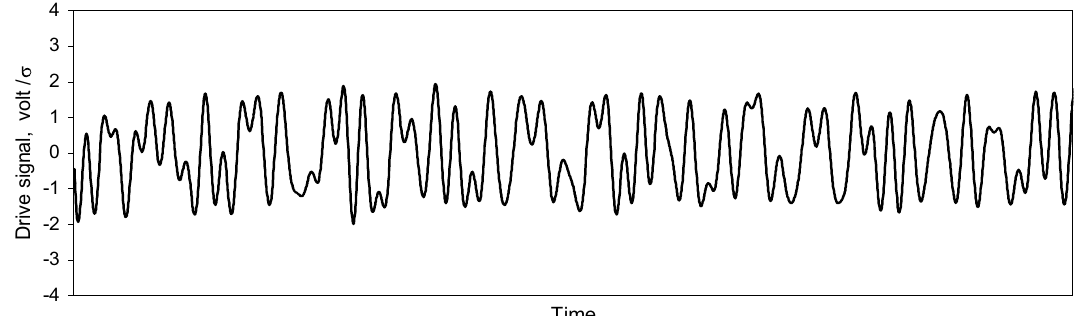
Fig. 3. Fragment of the non-Gaussian drive signal with kurtosis K =1.7 and crest factor CF = 2 . 0